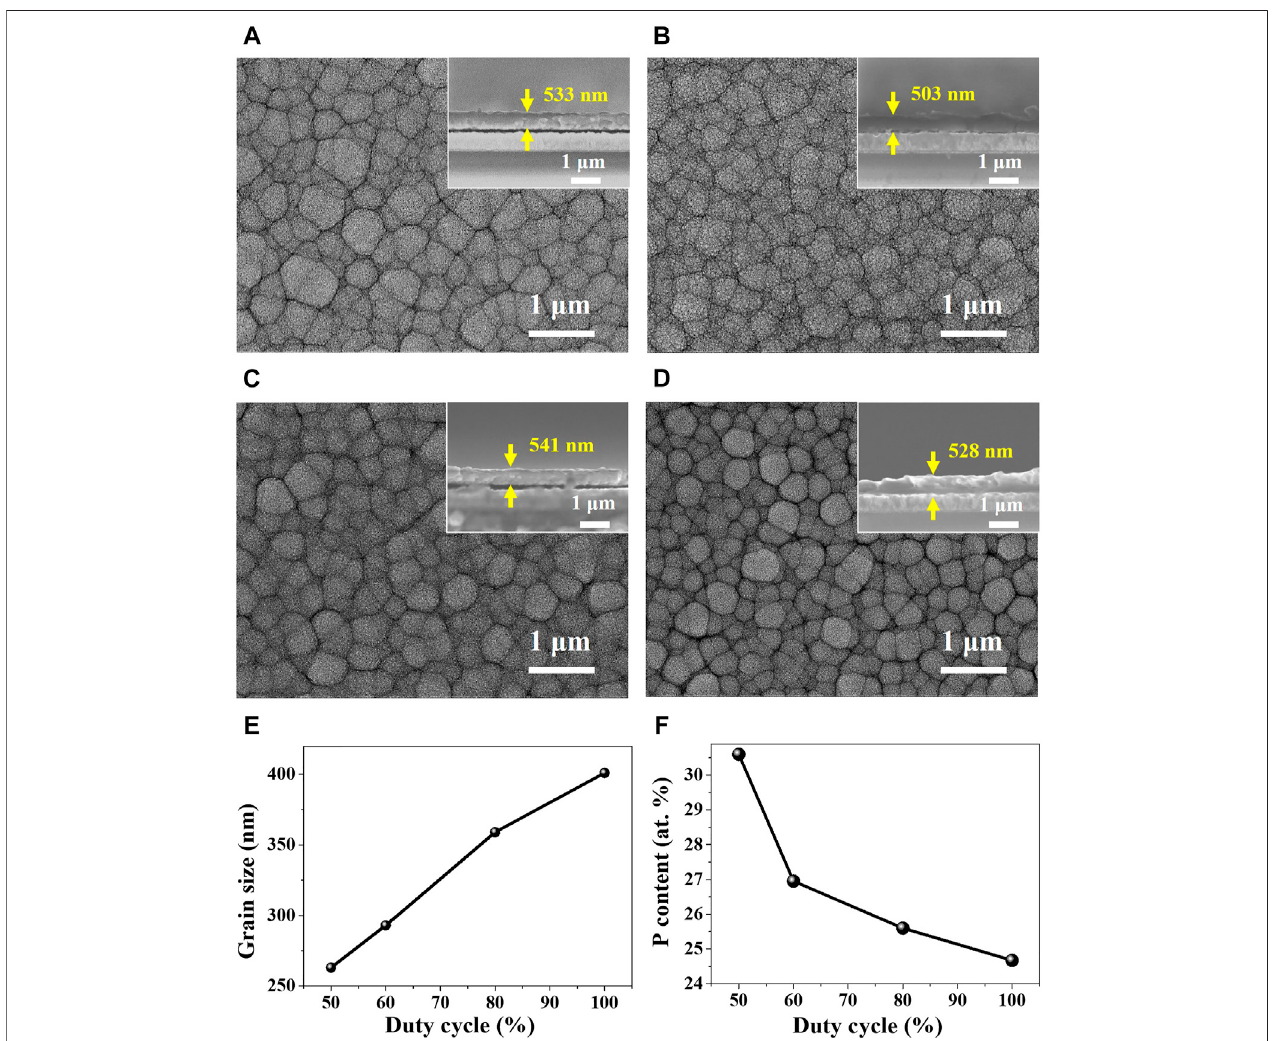
FIGURE 2 | Surface morphologies of Ni-P pulse-reverse electrodeposited at tailored duty cycles: (A) 100% (DC), (B) 80%, (C) 60% and (D) 50% (insets: cross- sectional views), and (E) the average grain size and (F) the phosphorous contents of the Ni-P electrodeposits as a function of duty cycles.